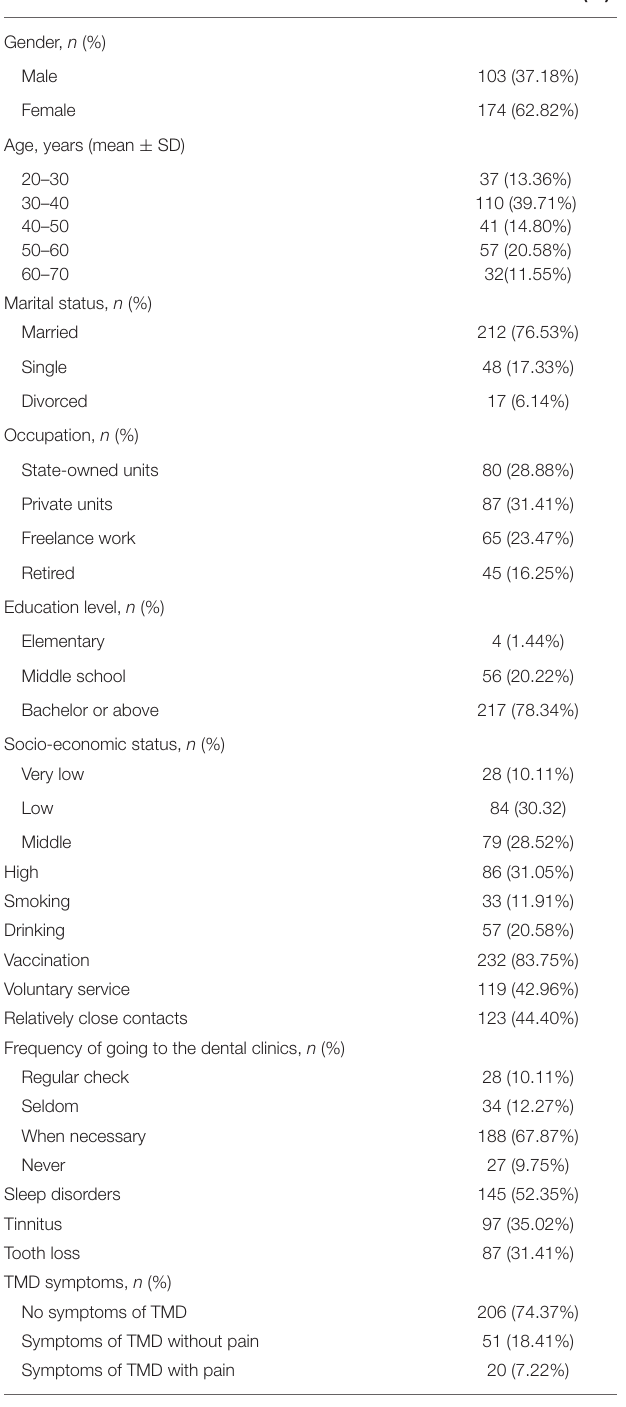
TABLE 1 | Demographic characteristics of patients included in the study. Variables